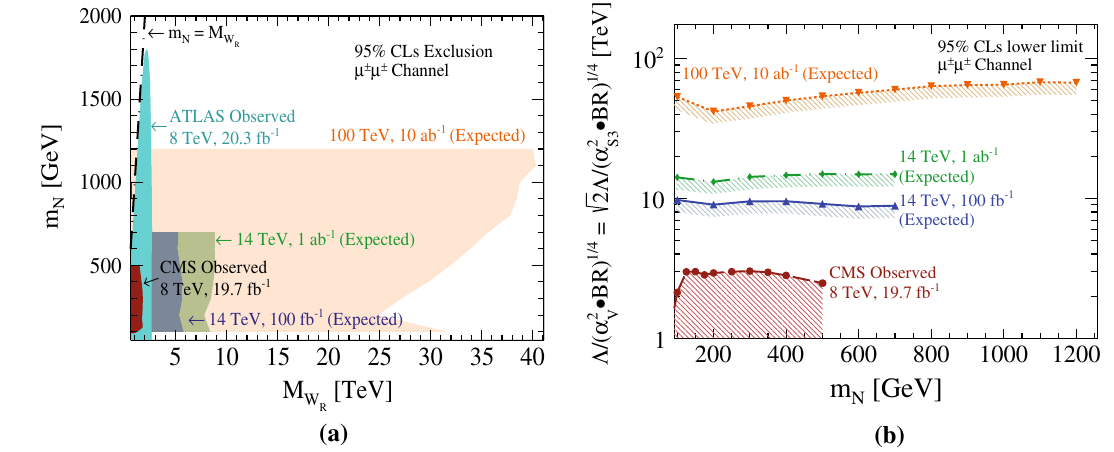
and expected 95% CL s sensitivities to the NEFT dimension-six opera- ( 6 ) ( 6 ) tors O and O in the μ ± μ ± channel for the collider configurations V S 3 in Fig. 2a ) and ( M /κ ) in the LRSM as well as (cid:11)/ 4 W R R R